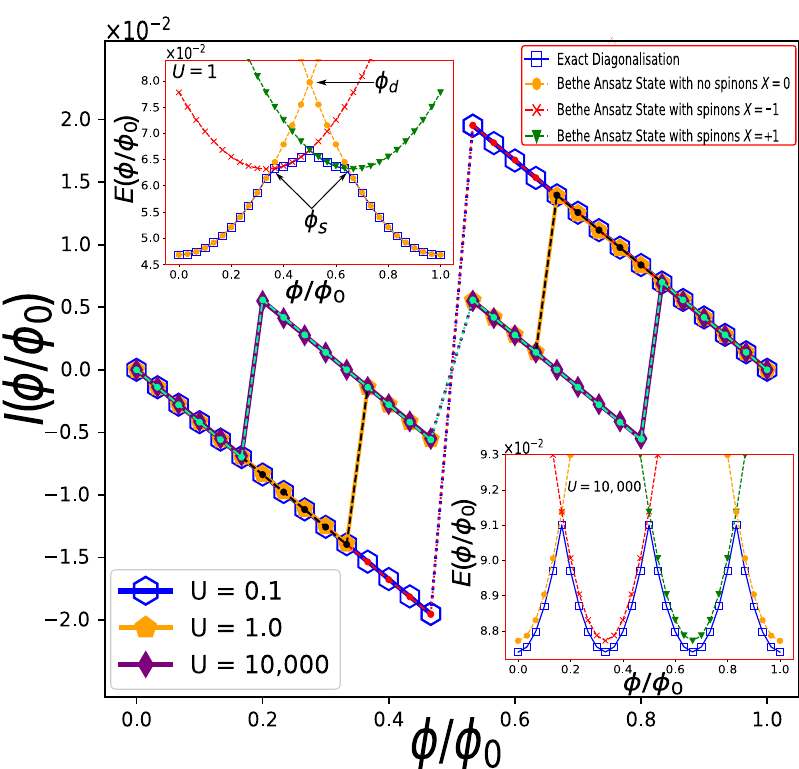
Figure 1: Persistent current I ( φ ) at incommensurate filling for SU(3) fermions with different interaction strengths U in the dilute filling regime of the Hubbard model. = 3 is monitored with the BA of the Sutherland- The exact diagonalization L = 30, N p Gaudin-Yang model. The red, black and green dots in the main figure depict the Bethe ansatz results for the persistent current for U = 0.1, 1.0 and 10,000 respectively. These dots are meant to be a guide to the eye, to aid in perceiving the fractionalization of the persistent current with increasing interaction Insets show how the BA energies need to be characterized by X (cid:54) = 0, to be the actual ground state. At U = 0, the ground state energy is a periodic sequence of parabolas meeting at degeneracy points φ = 1 / 2 for the case in this figure). The values of the flux at which spinons are ( φ d d created φ have been included as an example in the top inset, which for an interaction s U = 1, range from 0.37 to